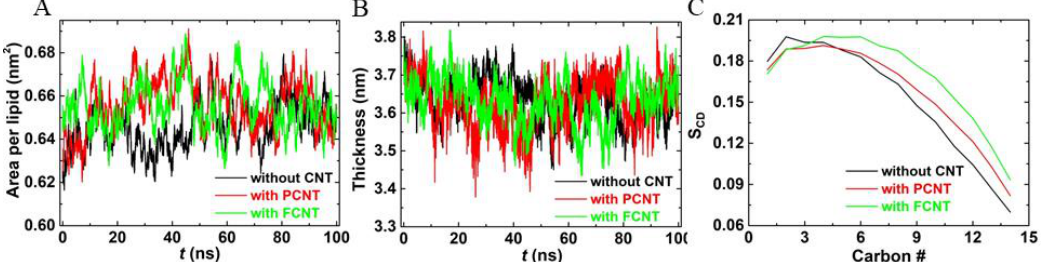
Figure 5. The effects of carbon nanotubes (CNT) on the membrane structure compared with the pure bilayer. ( A ) Area per lipid, ( B ) the bilayer thickness, and ( C ) deuterium order parameter for a lipid chain.